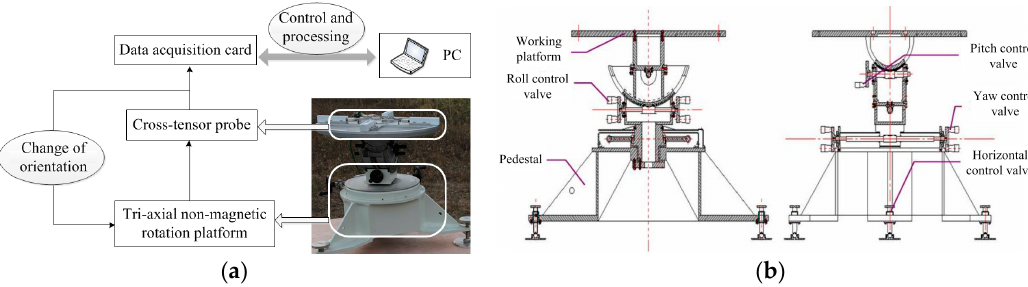
Figure 7. Calibration experiment of the magnetic gradient tensor system. ( a ) Experimental setup to acquire orientation data; ( b ) Design of the three-axis nonmagnetic rotation platform structure.